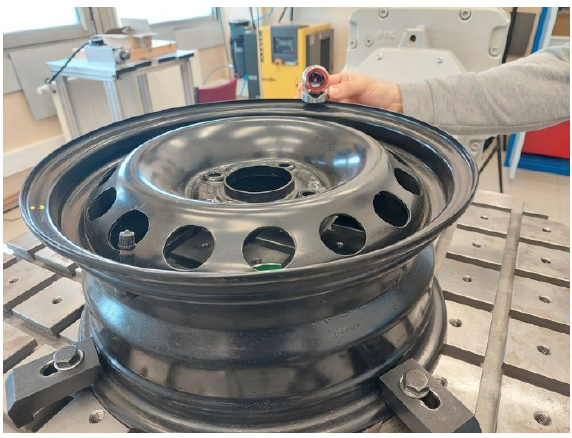
Figure 13. Retroreflector in the holder and detail during programming.